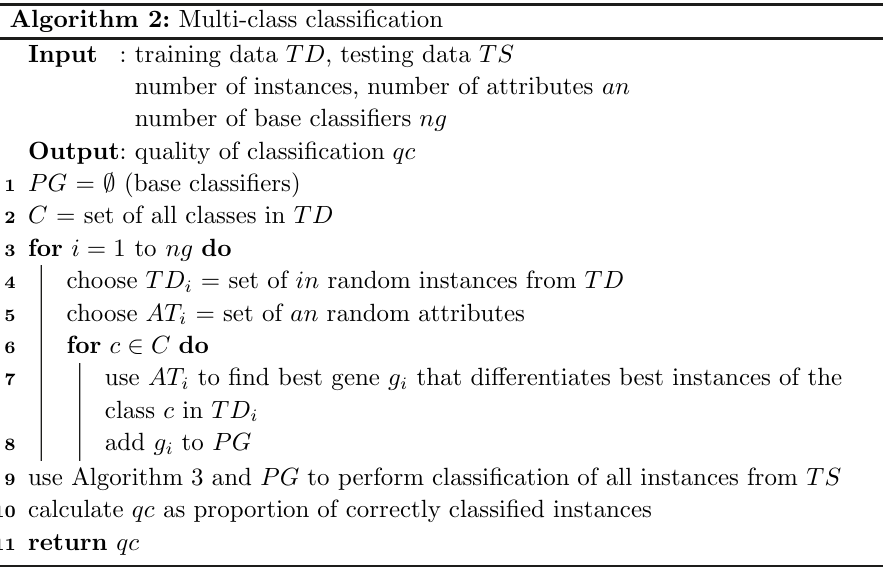
Algorithm 2: Multi-class classification